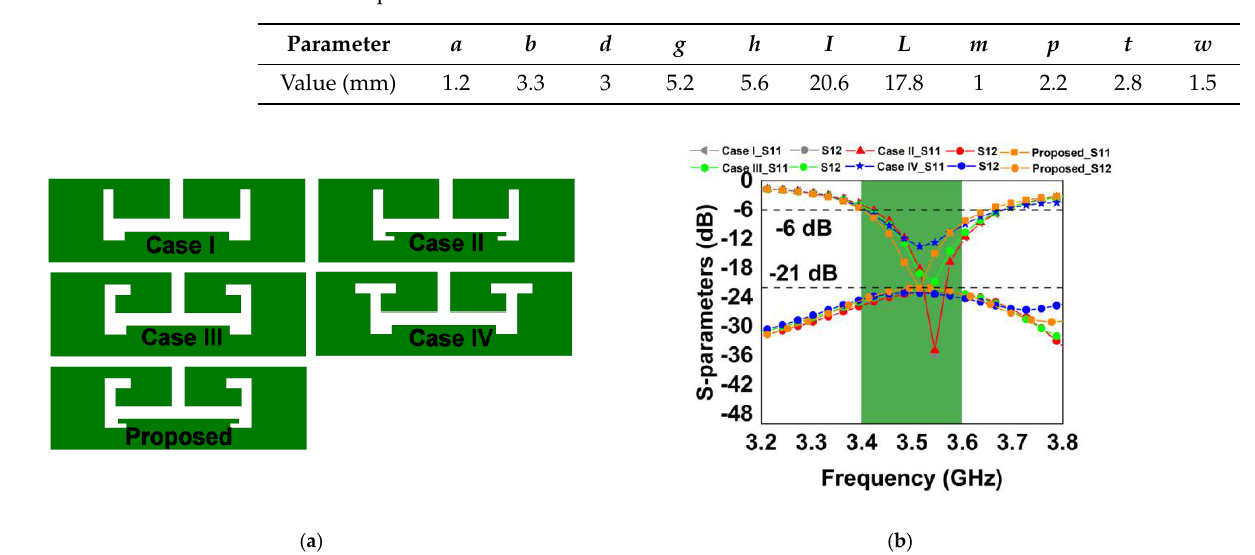
Figure 2. ( a ) Design evolution ( b ) S-parameters of design evolution.